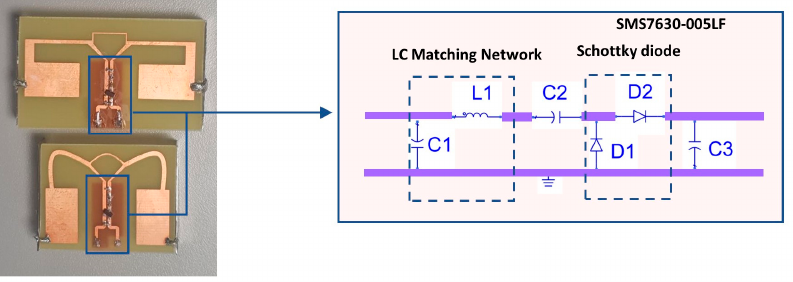
Figure 12. Manufactured rectenna with the rectifier schematic. The conversion efficiency as a function of the power density is presented in Figure 13.